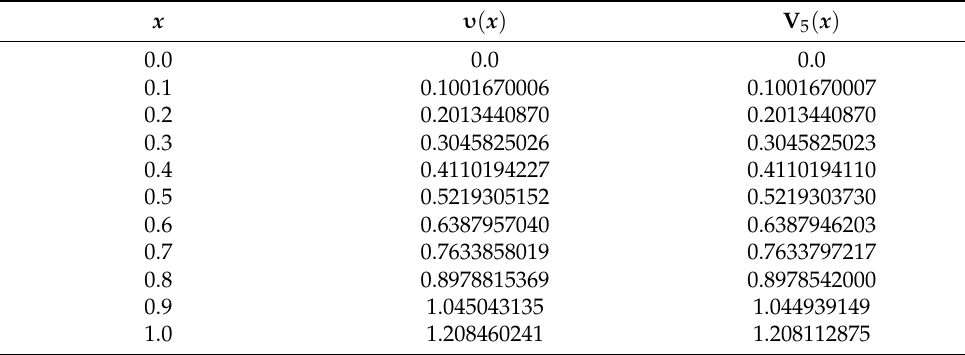
Table 2. A comparison between the numerical results of υ ( x ) and V 5 ( x )